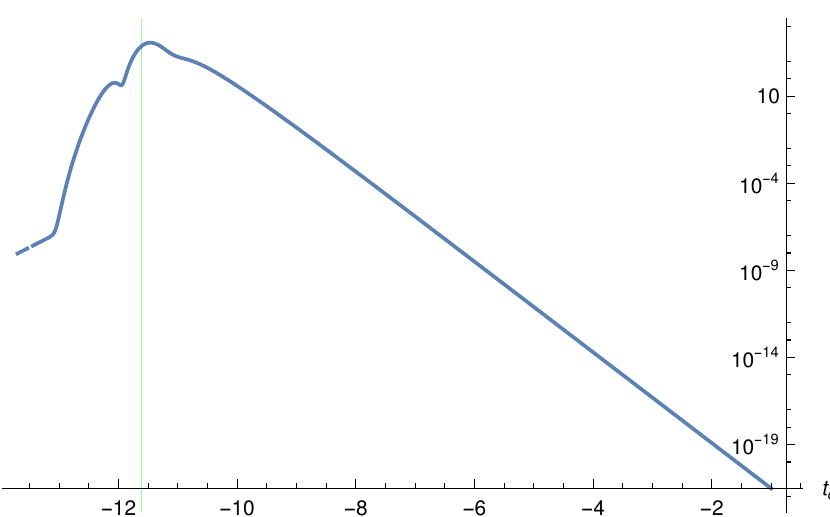
Figure 8. The Kretschmann scalar near the transition surface denoted by the vertical line for the case α 1 = 0. Here m = 10 6 , ( ω cc , ω cb ) = ( δ c /3 m ,0 ) , and ( ω bb , ω bc ) = ( δ b /3 m , − δ b /3 m ) , so that Ω ( Ω c ) = ( 0, δ c /3 m > 0 ) , where δ i ’s are given by Equation b ,